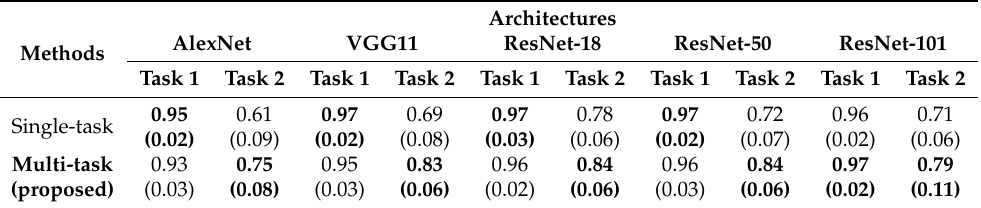
Table 6. Comparisons with single models and multi-task models, in terms of task-specific accuracy. The best values for each architecture are in bold. The mean accuracy and standard deviation are